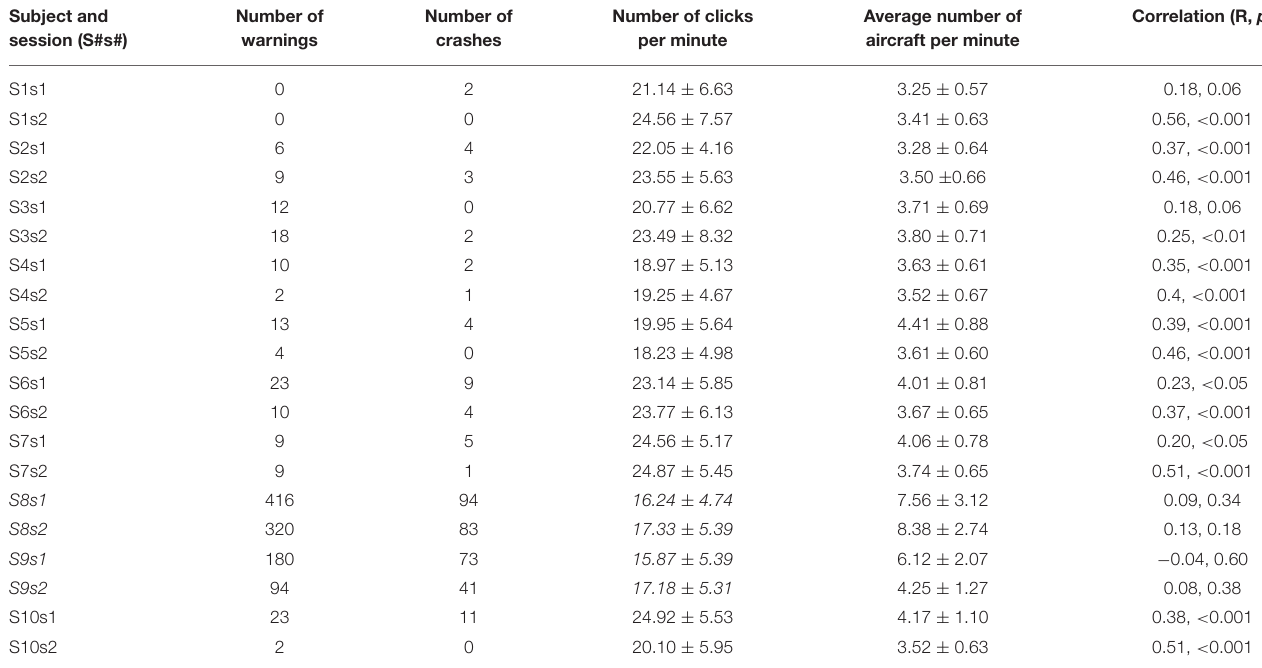
TABLE 1 | Summary of perfromacne and task related metrics from 20 sessions of 10